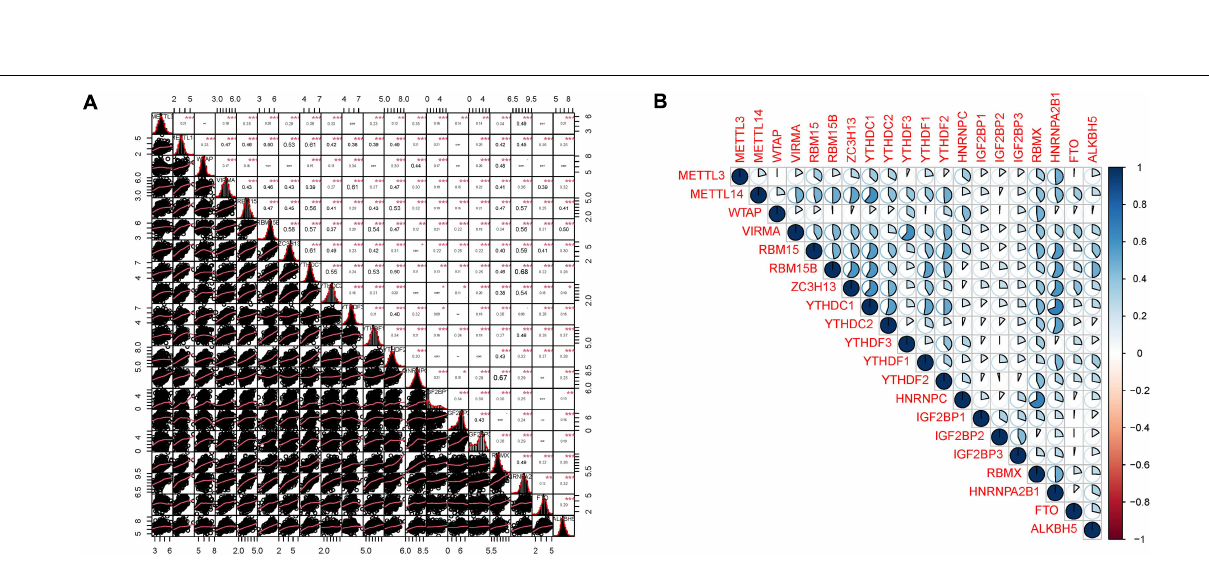
Frontiers in Cell and Developmental Biology |